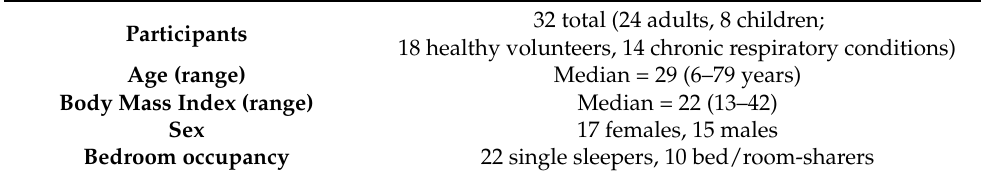
Table 1. Summary of the validation population characteristics and results.